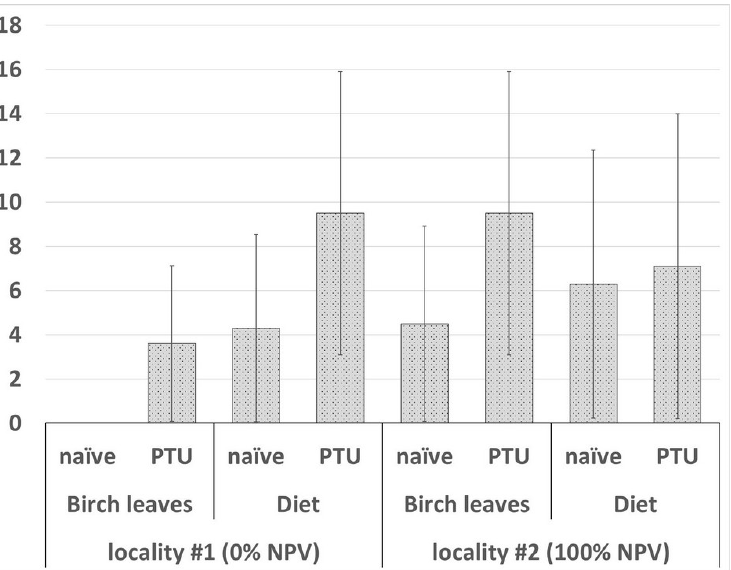
Figure 4. Microsporidia infection level in gypsy moth larvae 30 days after challenging with Nosema pyrausta spores. Statistical approach is as described in Figure 3. No statistically significant differences between the variants were